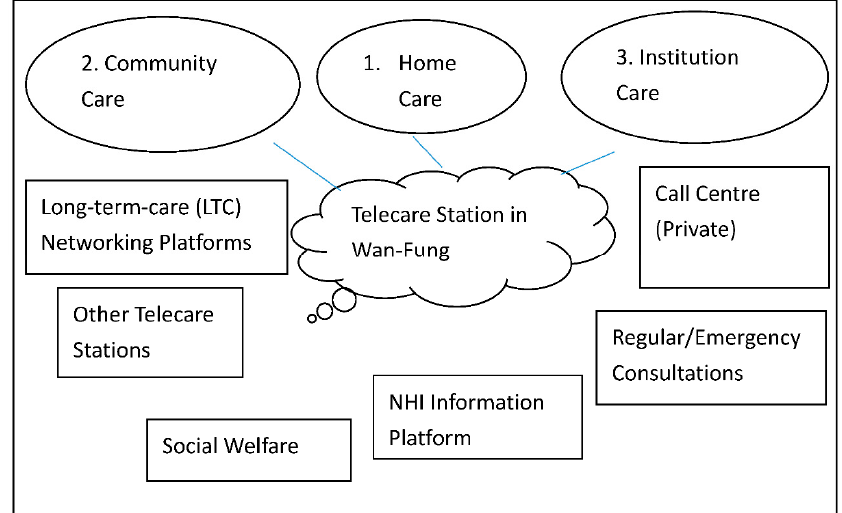
Figure 2. Telecare (TC) in Taiwan (source: Department of Health, Taiwan, 2009).